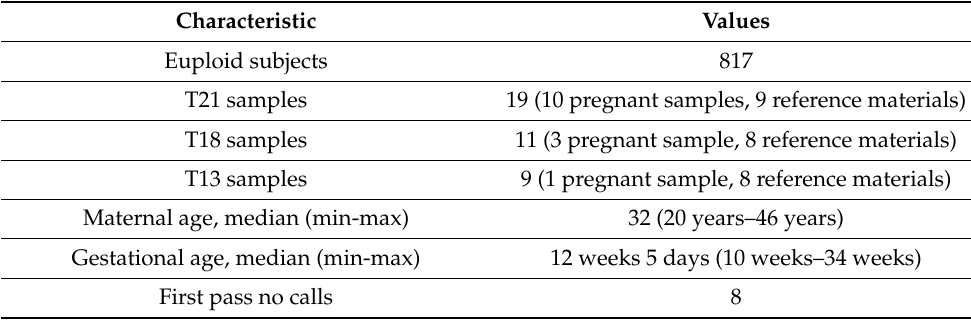
Table 1. Characteristics of study subjects.